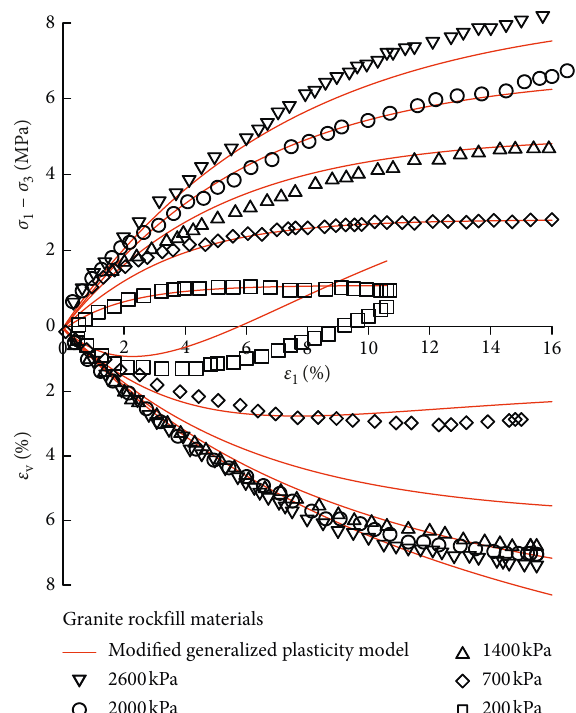
Figure 9: Predicted results of CT test using modified generalized plasticity model.